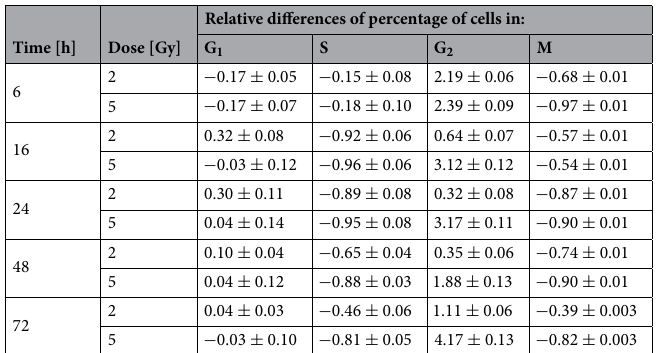
Table 2. Relative differences with respect to the sham of experimental percentages of cells in each cell-cycle phase for different doses (2 Gy, 5 Gy) at each time point.